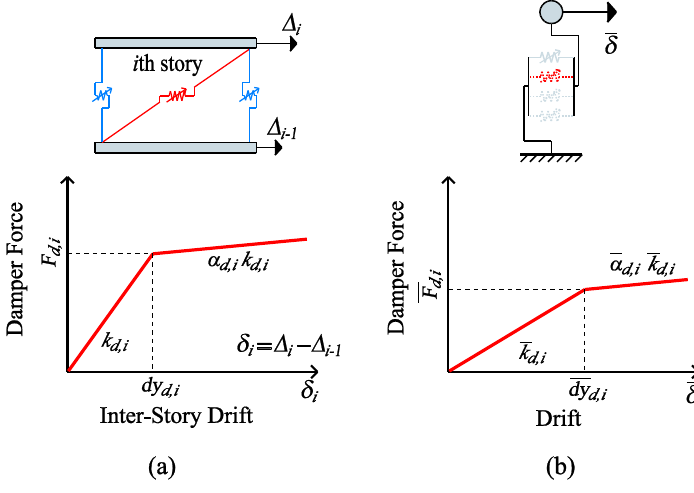
Figure 2. Skeleton curves of the dampers and inelastic springs: ( a ) damper force versus inter-story drift curve of the damper at the i th story in the MDOF system and ( b ) force versus drift curve of the i th spring in the SDOF system.